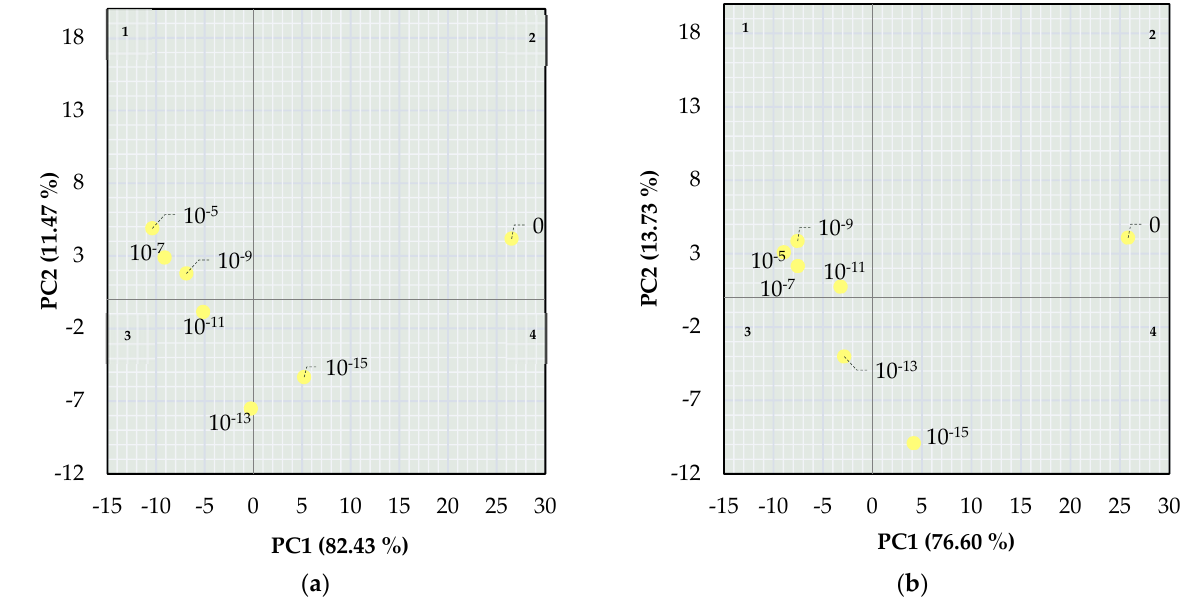
Figure 4. Principal components analysis (PCA) plot of TCS concentrations (10 − 15 –10 − 5 M) distinguished with an electronic tongue sensor for MT ( a ) and MMW ( b ).